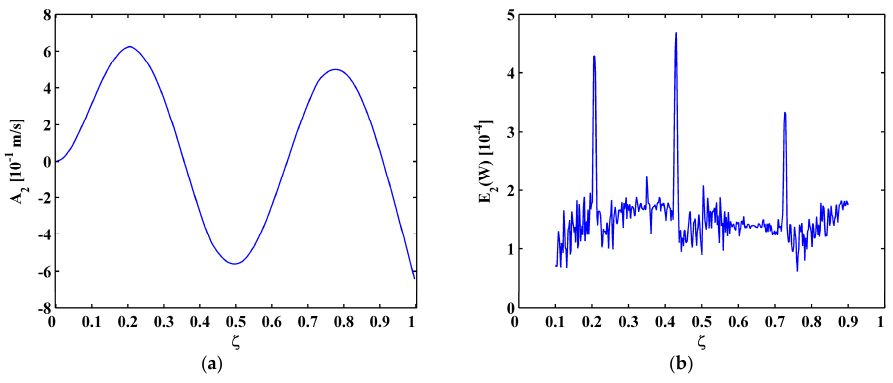
Figure 15. Second-level approximation of the fourth mode shape ( a ) and MRM-TKE ( b ) for Scenario I.